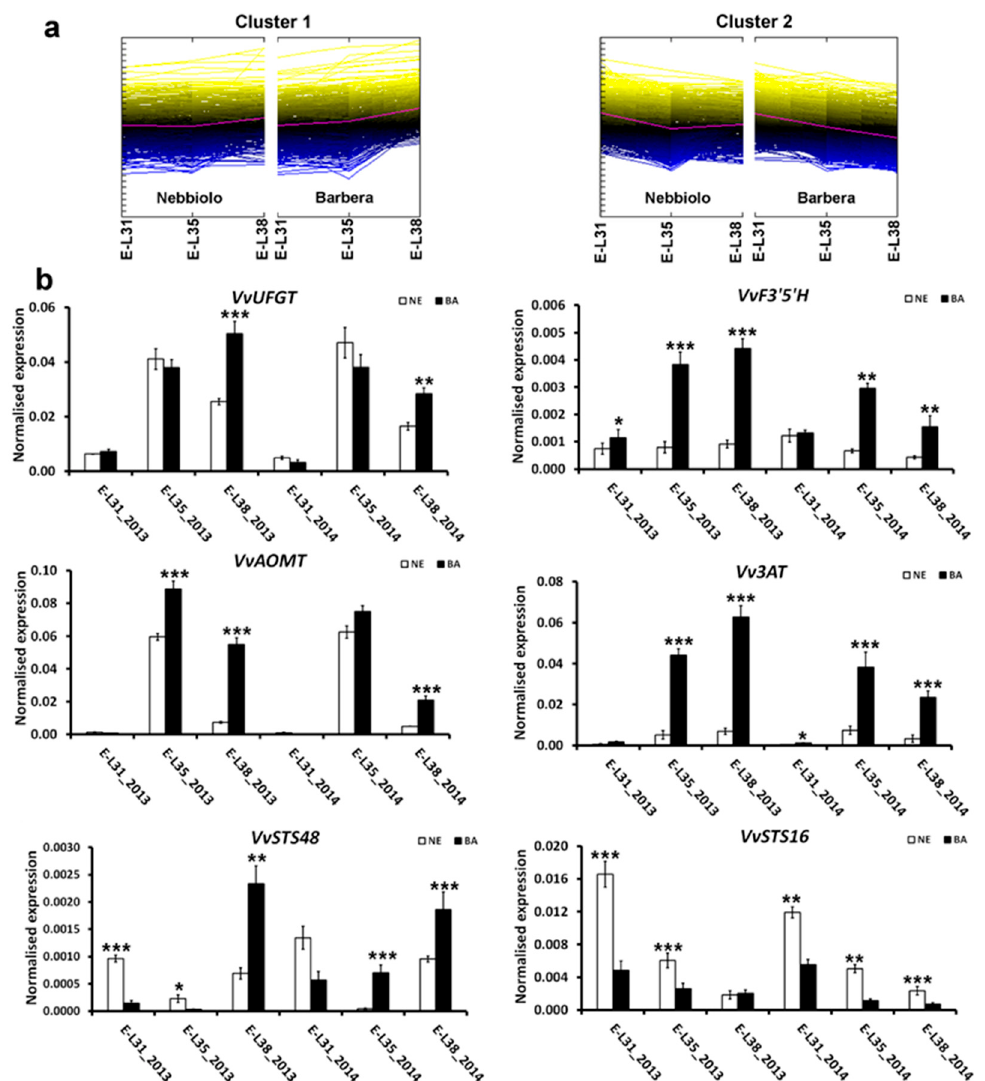
Figure 2. Transcriptional reprogramming of secondary metabolism genes in ‘Nebbiolo’ and ‘Barbera’ during ripening. ‘Nebbiolo’ CVT71 (NE) and ‘Barbera’ CVT115 (BA) berries were collected in 2013 and 2014 at three developmental stages: pea size (E-L31), véraison (E-L35), and harvest at 24° BRIX (E-L38). ( a ) Clusters of differentially expressed genes (DEGs) showing upregulated (Cluster 1) and downregulated (Cluster 2) genes in ‘Barbera’. ( b ) Results of candidate gene expression analysis performed by RT-qPCR assay. Cluster 1: anthocyanin O-methyltransferase ( VvAOMT , VIT_01s0010g03510), UDP-glucose:flavonoid 3-O-glucosyltransferase ( VvUFGT , VIT_16s0039g02230), flavonoid 3 ′ ,5 ′ -hydroxylase ( VvF3 ′ 5 ′ H , VIT_06s0009g02810), anthocyanin acyltransferase ( Vv3AT , VIT_03s0017g00870) and stilbene synthase VvSTS48 (VIT_16s0100g01200). Cluster 2: stilbene synthase VvSTS16 (VIT_16s0100g00840). Ubiquitin and Actin genes were used as endogenous controls for the normalization of transcript levels. Three independent biological replicates with three technical replicates each were used for analysis. Statistically significant differences between ‘Nebbiolo’ and ‘Barbera’ in each developmental stage were attested by analysis of variance for p ≤ 0.05 (*), p ≤ 0.01 (**), and p ≤ 0.001